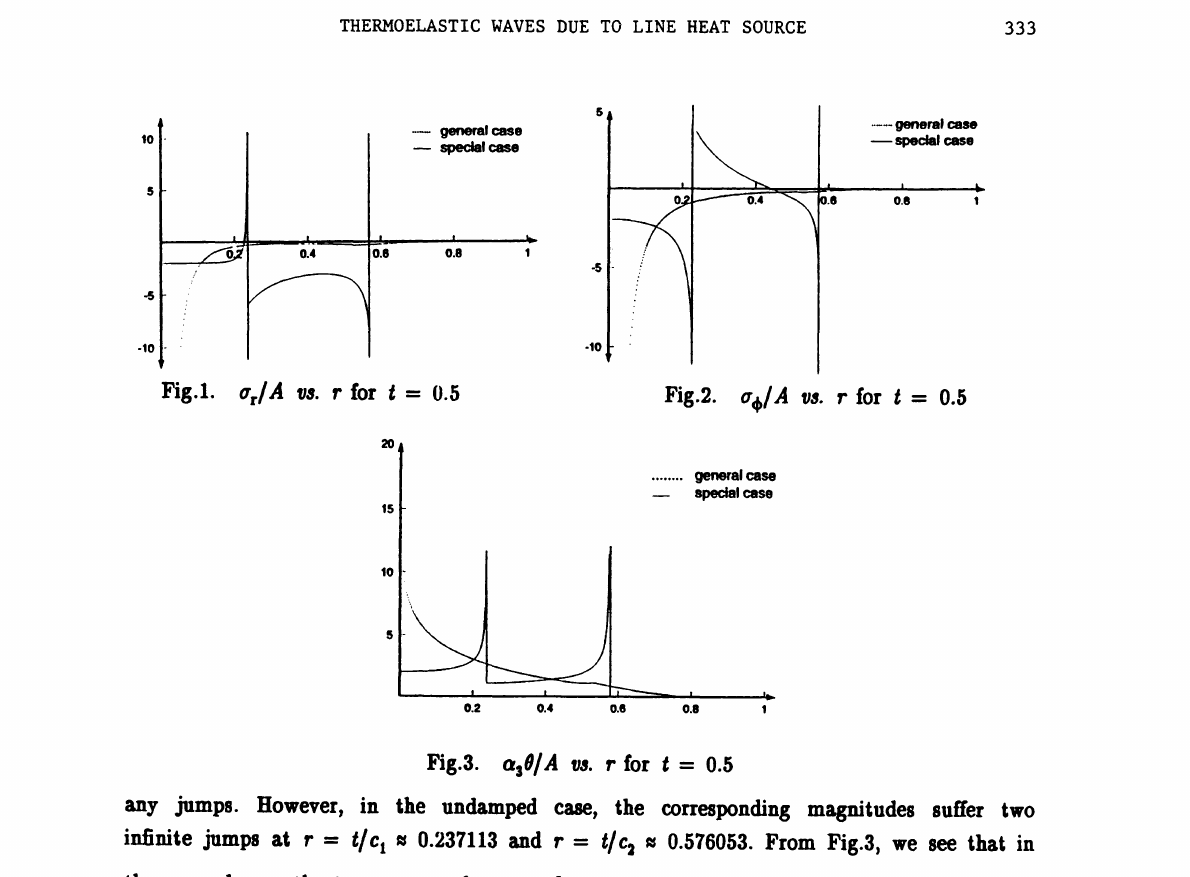
Fig.3. 30/A vs. r for